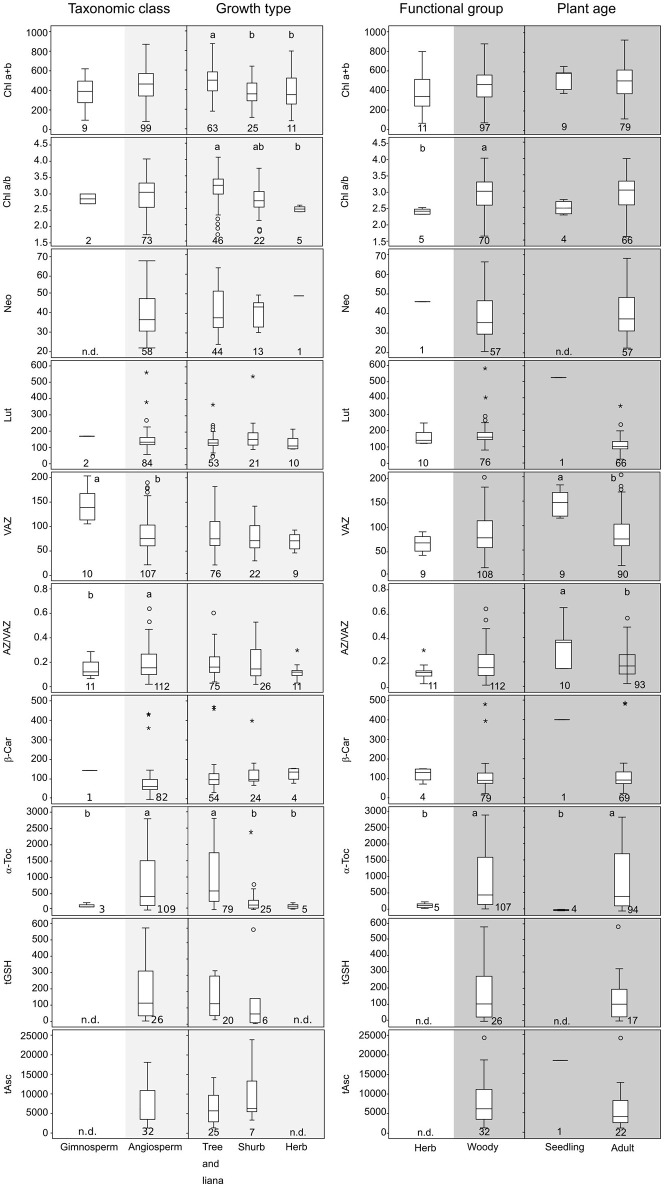
Boxplots showing the concentrations of the main photosynthetic pigments grouped considering different plant traits. (Left) Taxonomic class (Gymnosperm vs. Angiosperm) and growth type (Tree and liana, Shrub, and Herb) within angiosperms. (Right) Functional group (life style) (Herb vs. Woody) and plant age (Seedling and Adult) within woody. Total chlorophyll (Chl a+b) is expressed in μmol m−2. Carotenoids such as neoxanthin (Neo); lutein (Lut); pool of violaxanthin, anteraxanthin and zexanthin (VAZ); β-carotene (β-Car) and α-tocopherol (α-Toc) are expressed in mmol mol−1 of total Chl. Hydrophilic antioxidants such as glutathione (tGSH) and ascorbic acid (tAsc) are also expressed in mmol mol−1 of total Chl. De-epoxidation state of violaxanthin cycle (AZ/VAZ) is expressed in mol mol−1; Only data for non-stressed plants are included. Boxes cover 50% of the data; central lines represent the medians and whiskers represent the minimum and maximum values among non-atypical data. Open circles and asterisk represent outliers and extreme outliers, respectively. The number of reported data (n) is shown below each box. Lowercase and upper case letters above the boxes denote significant differences (P < 0.05) among groups analyzed by one-way ANOVA (normally distributed data) or by Kruskal-Wallis ANOVA (non-normally distributed data).